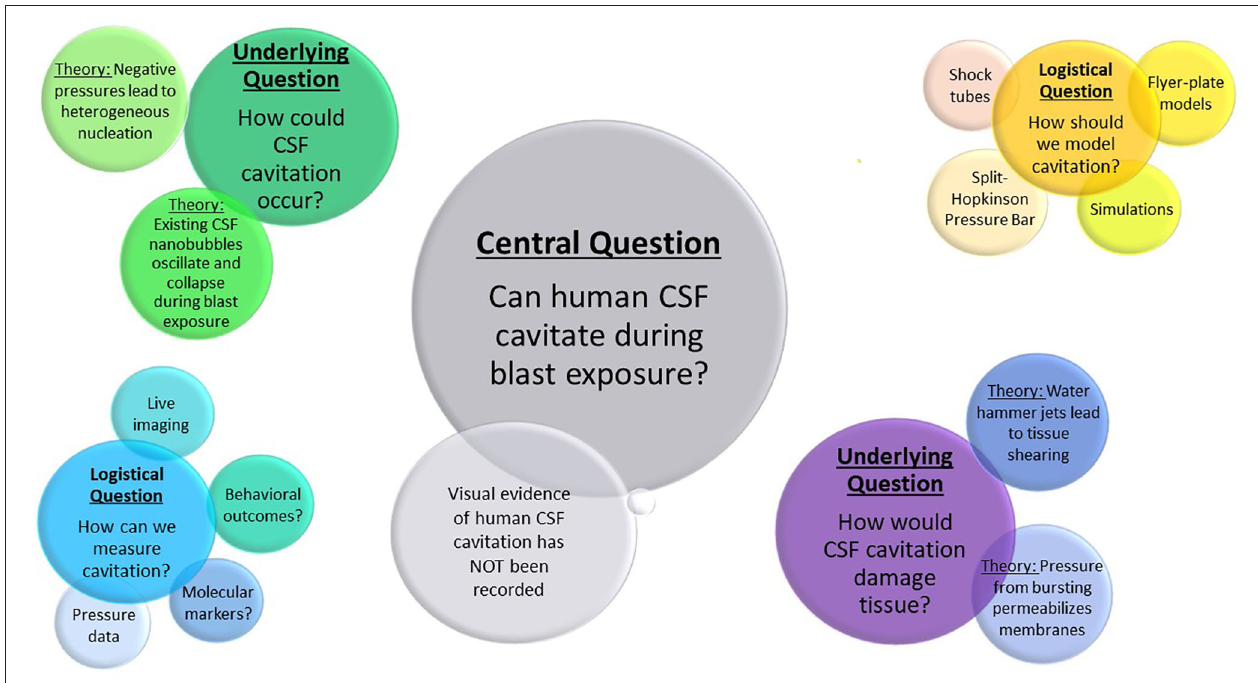
FIGURE 1 | Outstanding questions and debates in cavitation research described in this review. The largest bubble represents the central question of cavitation in bTBI research. Underlying questions and their theoretical solutions are labeled in the second largest bubble clusters, with logistical questions and possible approaches shown in the smallest